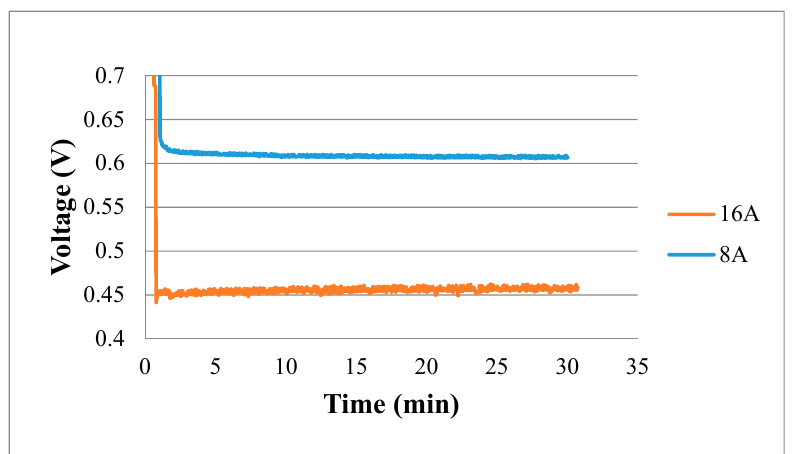
Figure 13. Real-time measurement of temperature. Sensors 2018 , 18 , x